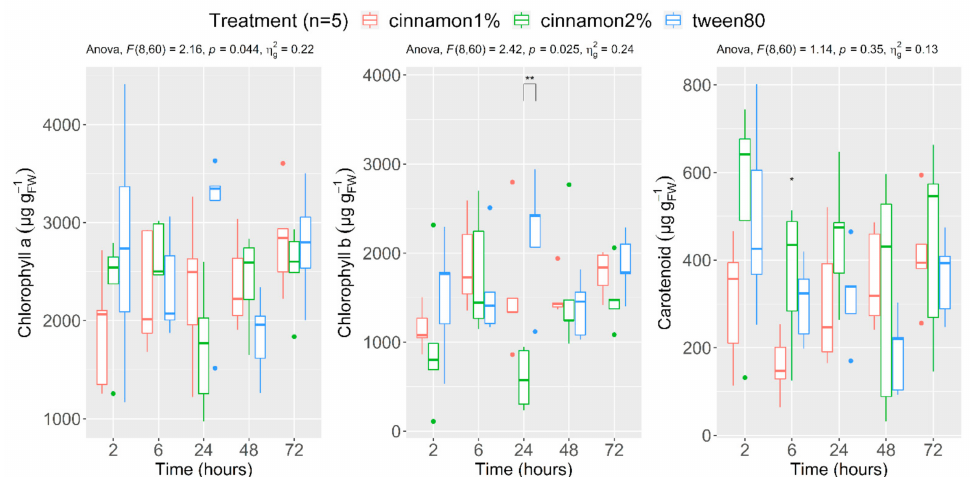
Figure 3. Effect of C. cassia EO (CEO) (1 and 2% v / v ) and tween 80 application on photosynthetic pigment leaf content over time ( n = 5): ( left ) Chlorophyll a content ( µ g/g); ( center ) Chlorophyll b content ( µ g/g); ( right ) Carotenoid content ( µ g/g). Star on boxplot indicates significantly different distributions (* p < 0.05, ** p <